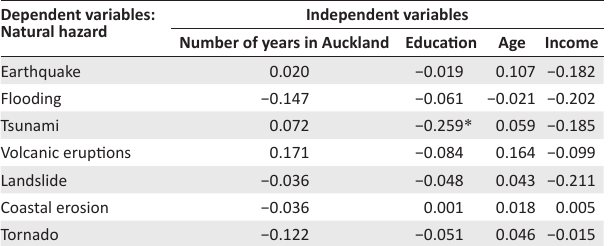
TABLE 3: Summary of correlations between social variables and perception of hazard